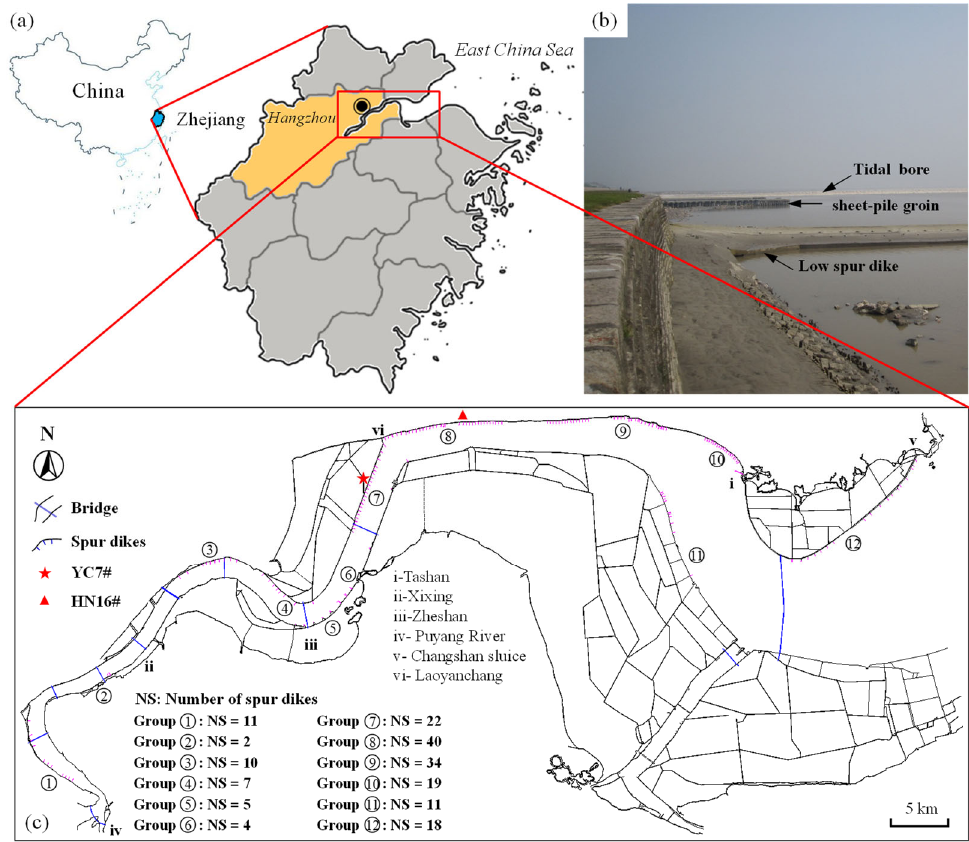
Figure 2. Study area: ( a ) Zhejiang Province in China: ( b ) spur dikes in the Qiantang River (QR) estuary; and ( c ) distribution diagram of spur dikes in the QR (2014).